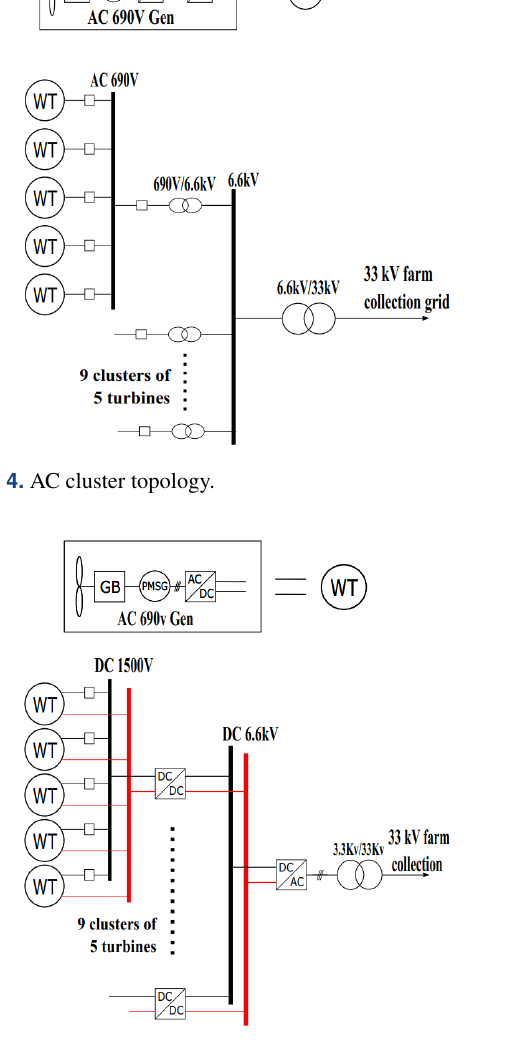
Figure 5. DC cluster